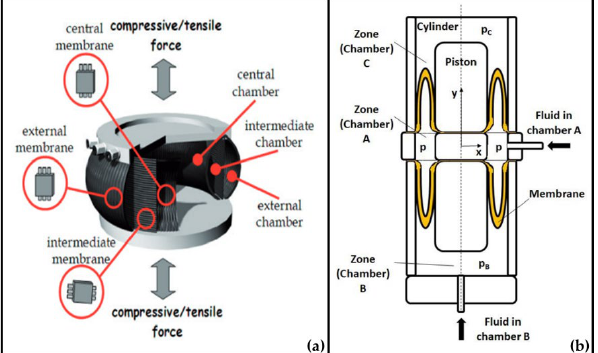
Figure 6. Bidirectional pneumatic deformable actuators: BiFAc [45] ( a ) and PATuCCo [46] ( b ).